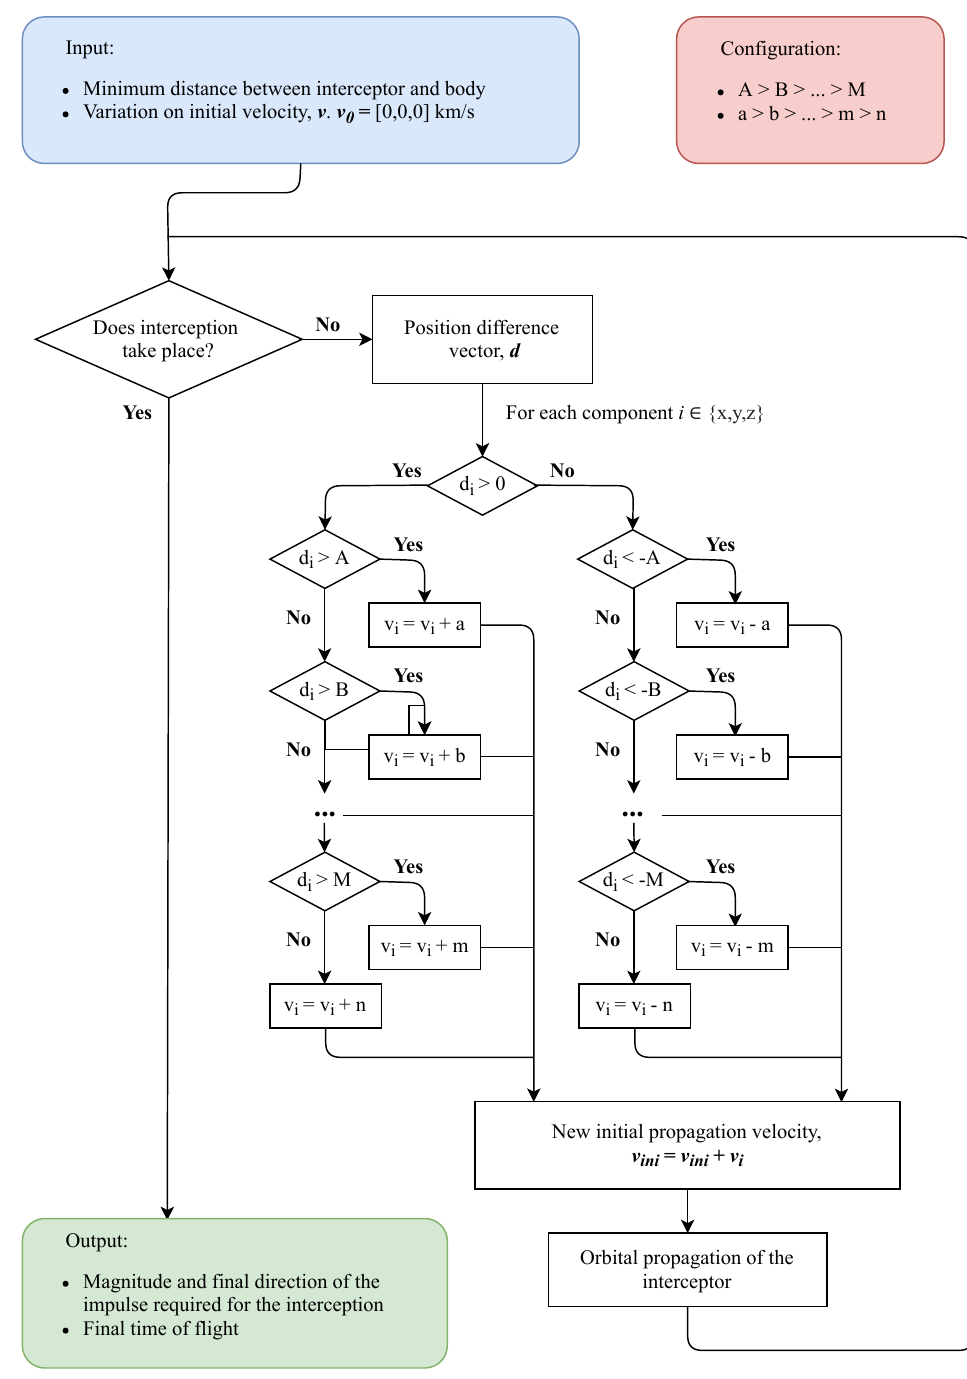
Figure 3. Flowchart of the iterative scheme developed for the correction of the impulse applied on the interceptor